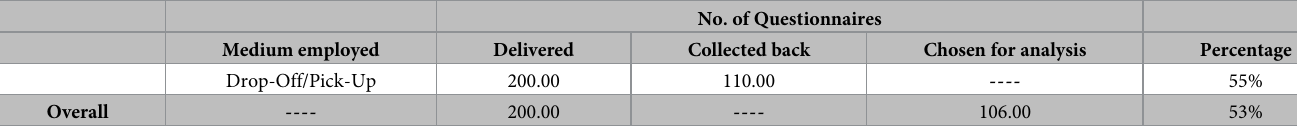
Table 2. Particulars of the 2 nd questionnaire